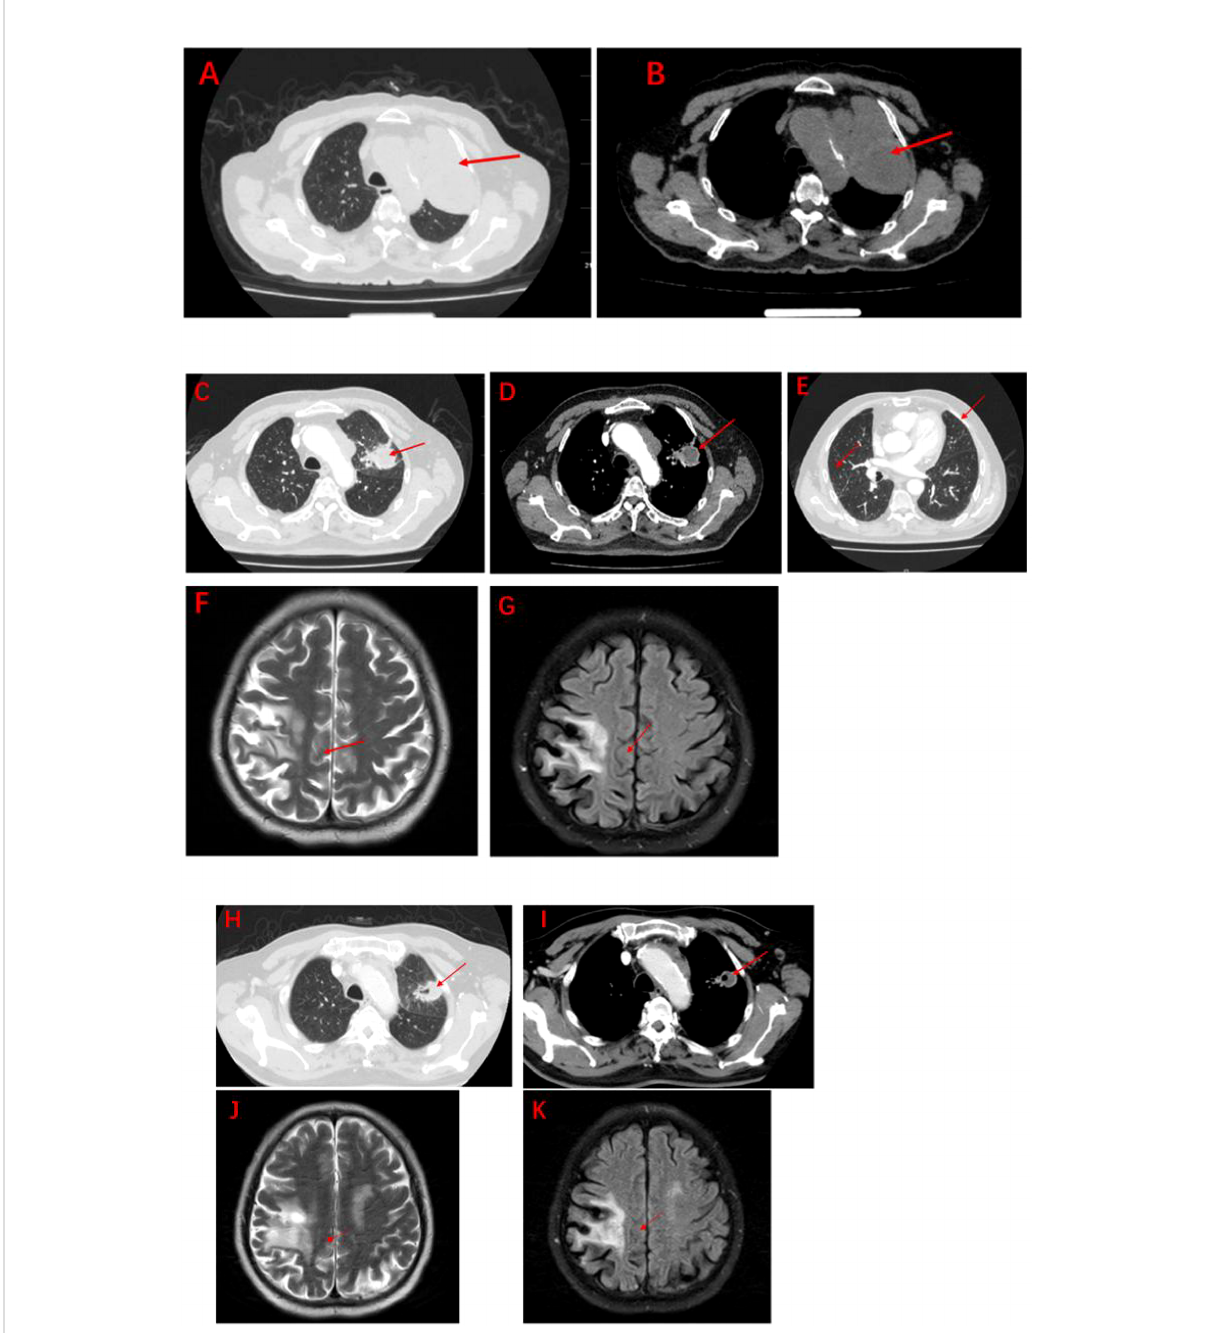
FIGURE 3 Imaging after anti-tumour therapy (A – K) . (A, B): Signi fi cant increase in lung lesions and bilateral lung metastases after 1 course of pemetrexed in combination with carboplatin (measuring 5.5cm x5.7cm x7.1cm). (C-E): The second line of treatment was “ albumin paclitaxel + nedaplatin + PD-1 inhibitor (Sintilimab) ” , and the lung lesions and metastases were signi fi cantly reduced after 2 courses (measuring 3.3cm x2.8cm x4.6cm). The ef fi cacy assessment reached PR. (F, G) : Signi fi cant reduction of brain metastases after 2 courses of Sintilimab in combination with chemotherapy. (H, I): The lung lesions continue to shrink after 4 courses of Sintilimab in combination with chemotherapy (measuring 2.8cm x 2.4cm x 3.9cm). (J, K): Brain metastases barely detectable after 4 courses of Sintilimab in combination with